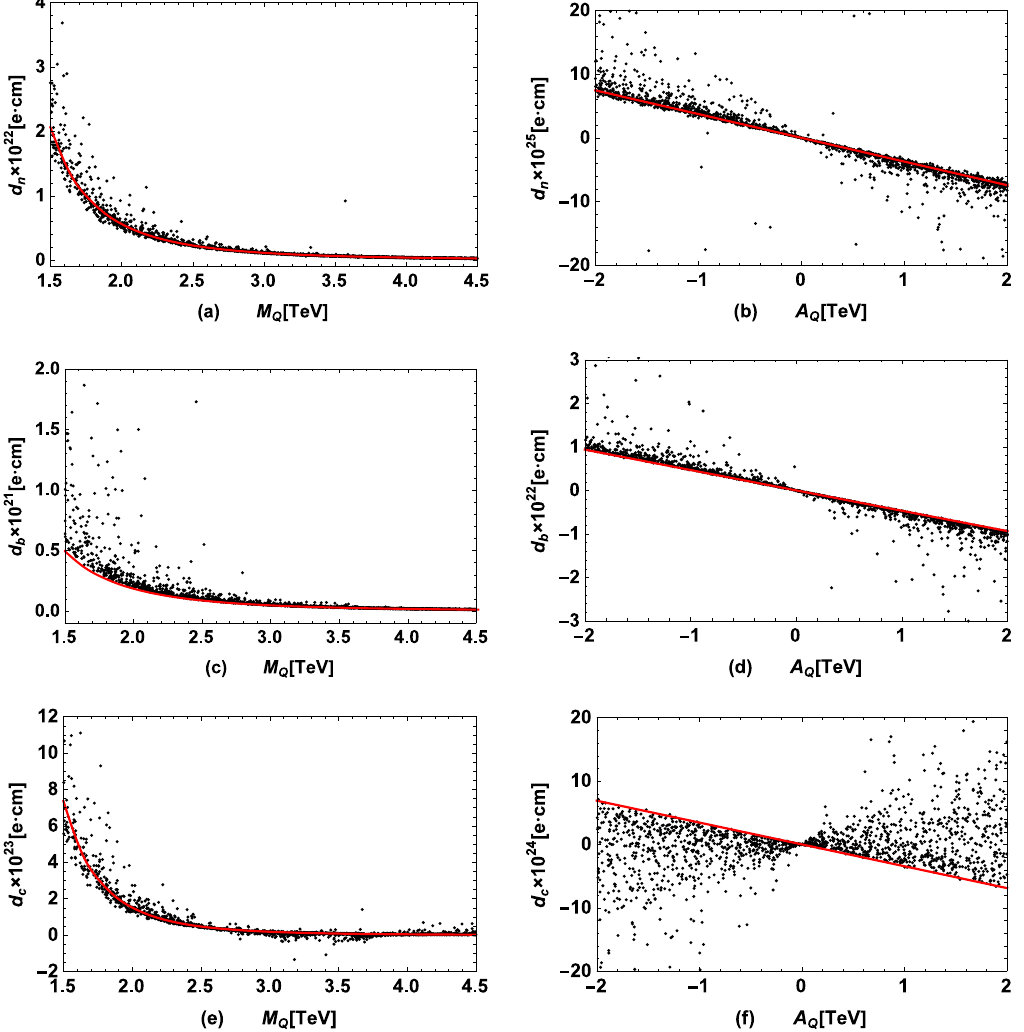
Figure 7 . Scanning the parameter space shown in eq. (4.2), (4.3), d n versus M Q , A Q are plotted respectively, where the red lines denote the corresponding MSSM predictions in the same parameter space. Similarly, d b;c versus M Q , A Q are also